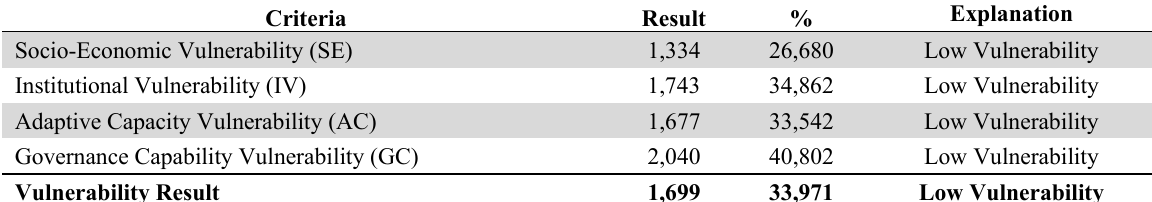
Evaluation of the vulnerability of the TNI-Polri power relations on Governance Capability (GC) vulnerability variable consists of five sub-variables, namely the Con fl ict (CF) sub-variable with a vulnerability value of 0.692 (53.34%) in the medium category. The Effectiveness of Policies (EP) sub-variable has a vulnerability value of 0.267 (30%). The Influence On Political Process (IP) sub-variable has a vulnerability value of 0.510 (40%). The Participatory Decision Making (PD) sub-variable has a vulnerability value of 0.418 (43.34%) in the medium category. The Barriers To Adaptation (BA) sub- variable has a vulnerability value of 0.152 (26.67%). Vulnerability evaluation scores for power relationship of TNI-Polri post-1998 reformation era.